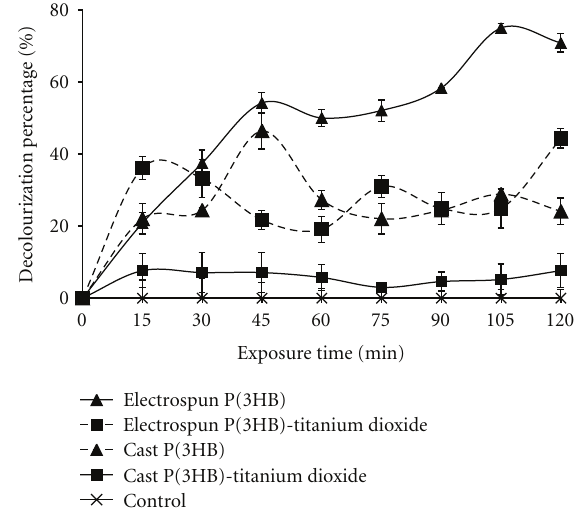
Figure 2: The decolorization percentage of MG via adsorption process over time using cast and electrospun P(3HB) and P(3HB)- 50wt% TiO 2